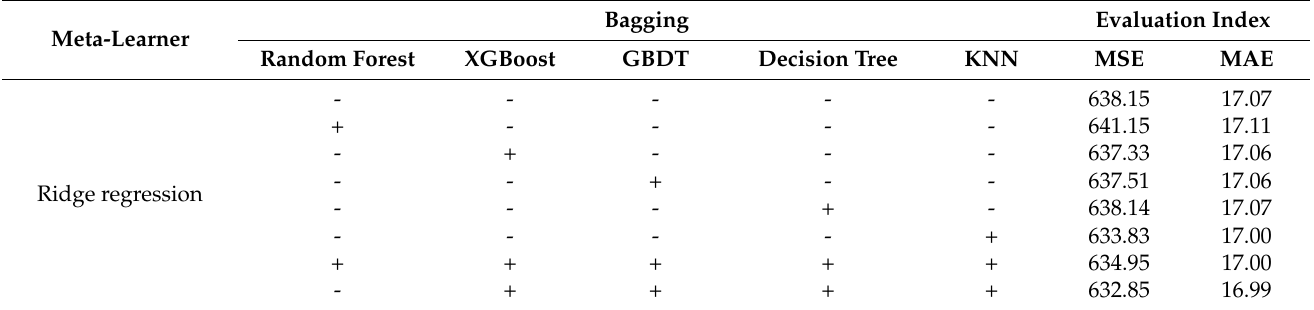
Table 5. The Ba-Stacking model prediction effect of different meta-learners. Meta-Learner